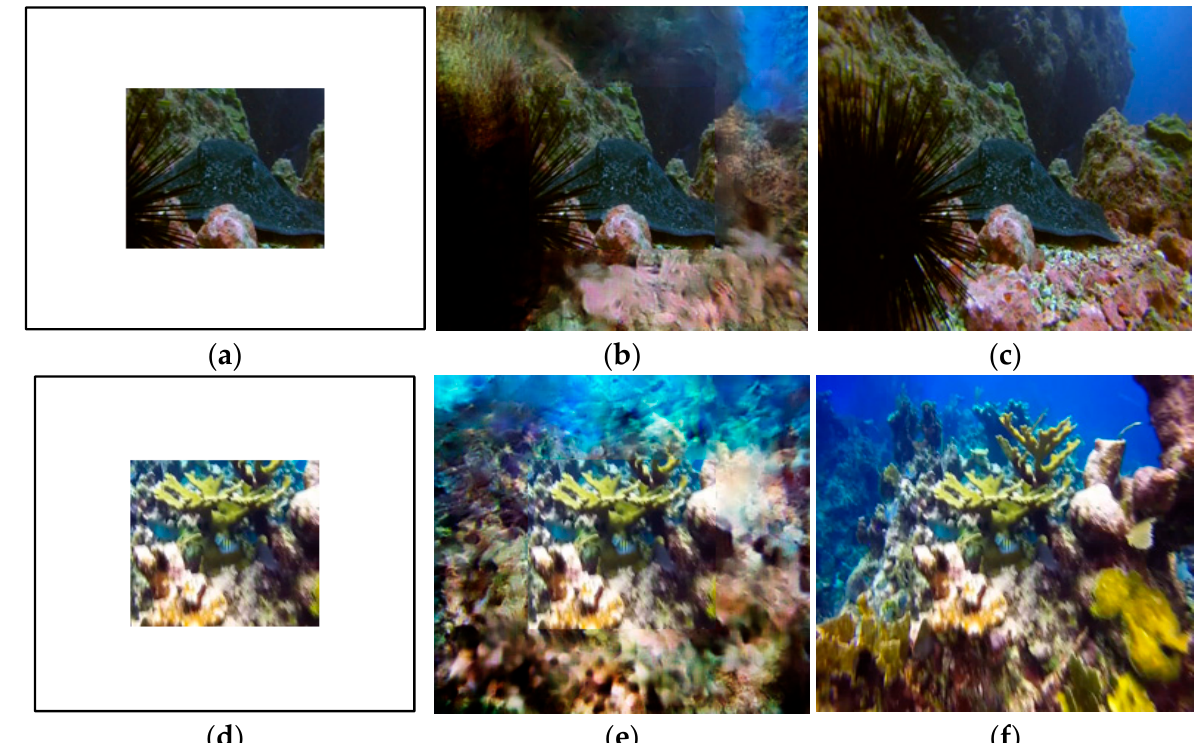
Figure 5. Testing of the test video frames extracted at 30 fps using different epoch models trained on the training dataset.